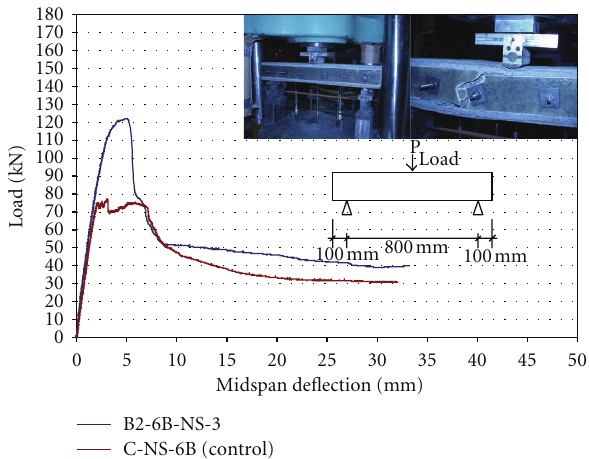
Figure 35: Load versus midspan deflection of RC beam B3-S-2.